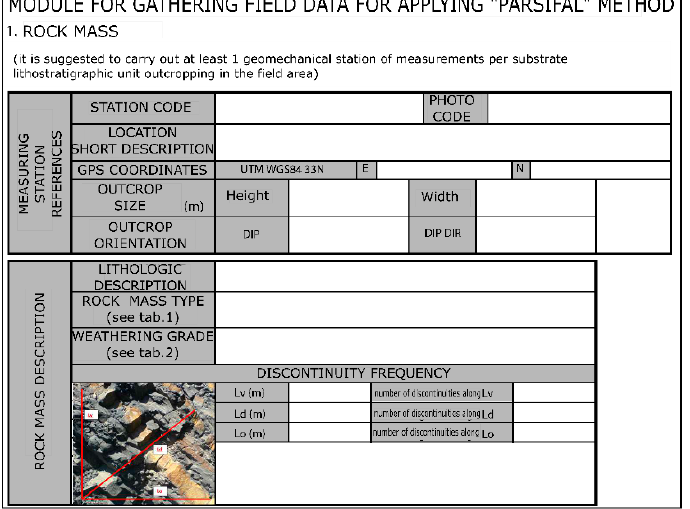
Figure 1. Example of the form (for rock masses) for data collecting used in the field survey (modified from the original form in Italian).